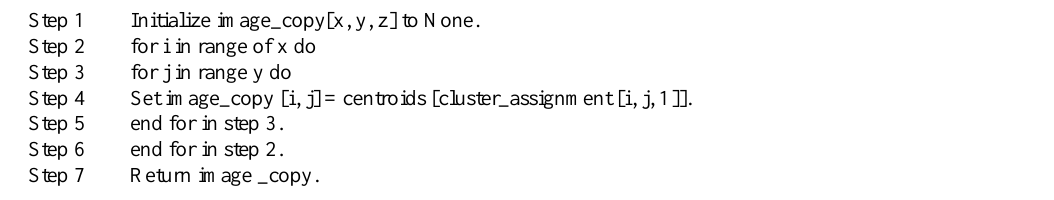
Table 2. Colour component for each cluster to superimpose RGB